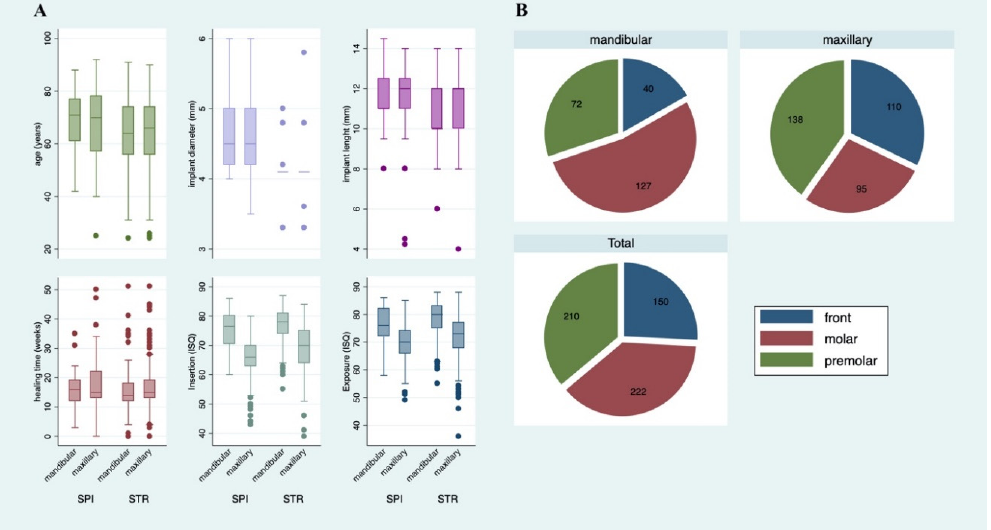
Figure 5. Distribution of study variables among the study groups. Age, implant diameter, implant length, healing time (in weeks), ISQ values at insertion, and ISQ values at exposure are grouped by implant region (maxillary vs. mandibular) and implant system (Straumann (STR) vs. Thommen (SPI)) (A). The distribution of implant localization (B).